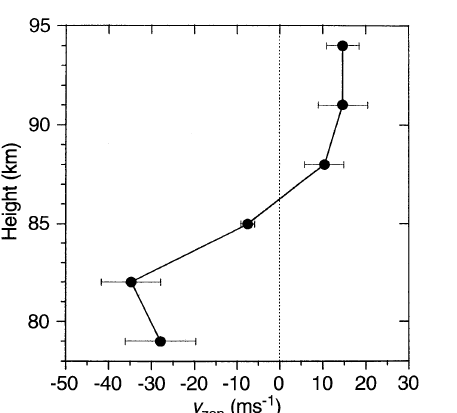
Fig. 14. Height profile of mean zonal wind deduced from MF-radar measurements carried out between 27 and 29 July 1994 between 21 and 01